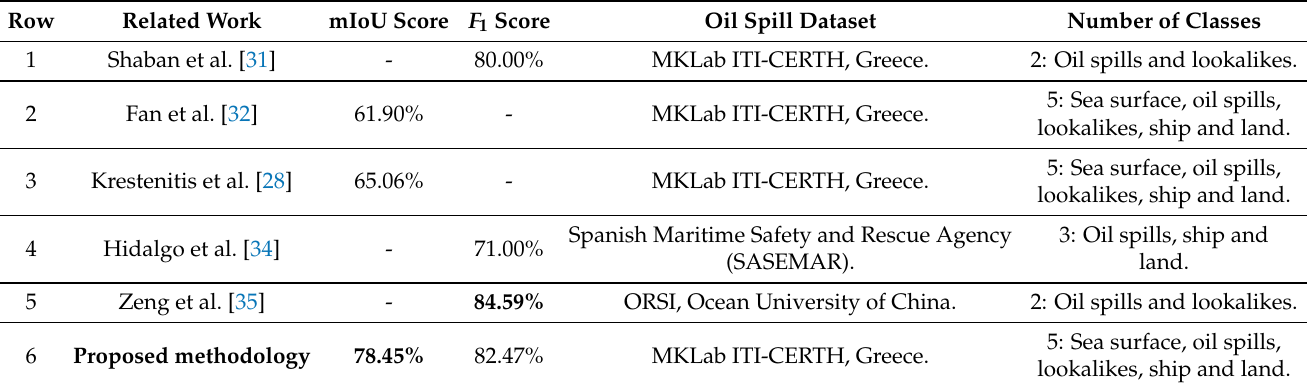
Table 2. Comparison of the proposed classification framework with state-of-the-art classification methods based on SAR images in terms of the SAR datasets, number of classes, mIoU, and F 1